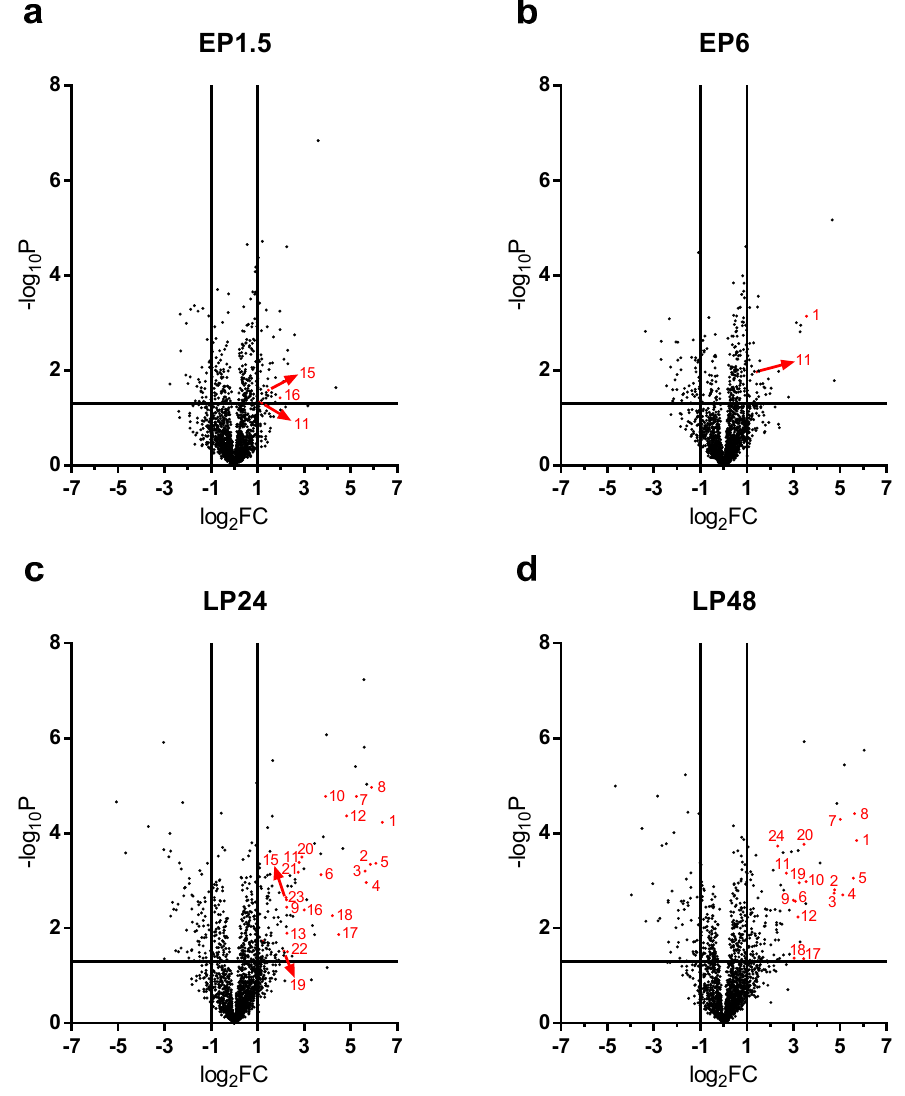
Figure 4. Renal proteome changes after LPS administration. The level of significance (given as –log 10 p values) is plotted against the fold changes (given as log 2 FC). Vertical lines mark 2x fold changes, while horizontal lines mark the significance level of 0.05. λ : APPs (1: Lcn-2, 2: fibrinogen- α , 3: fibrinogen- β , 4: fibrinogen- γ , 5: complement C3, 6: ceruloplasmin, 7: haptoglobin, 8: hemopexin, 9: serum amyloid